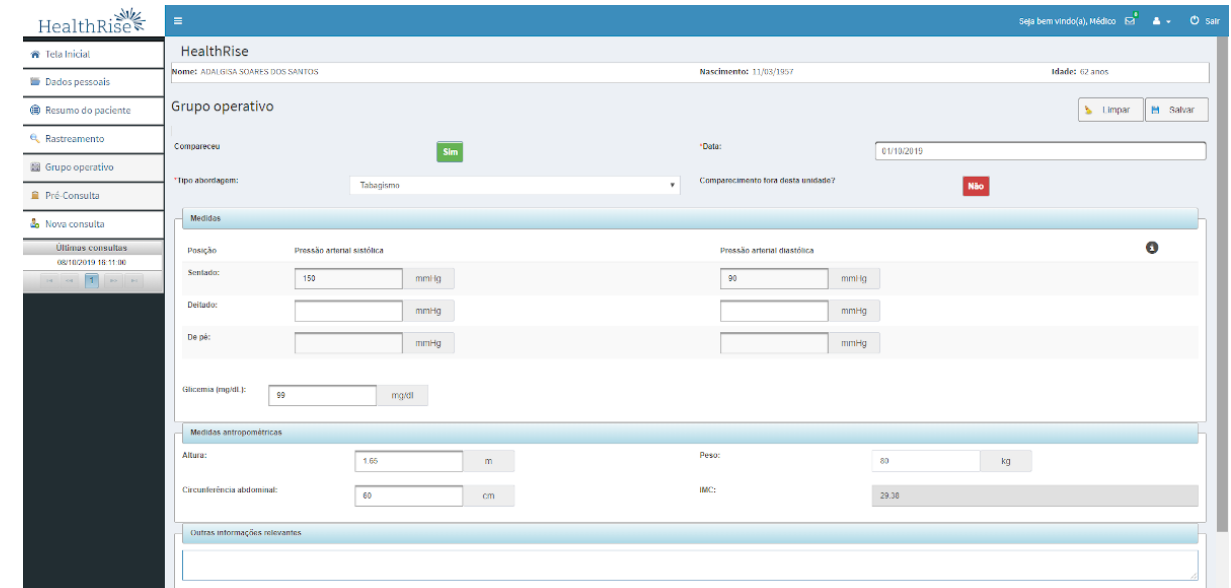
Figure 5. Health educational groups screen.